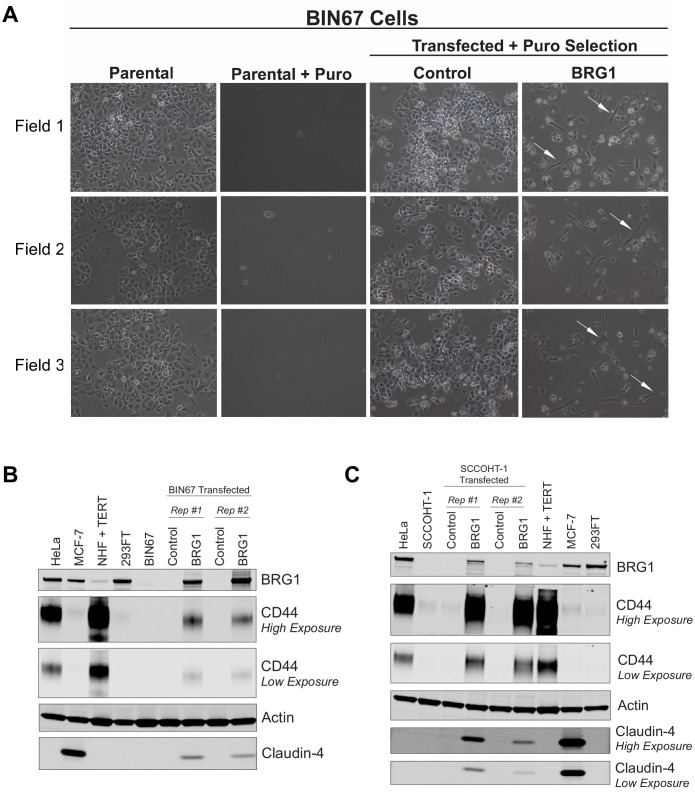
Morphology and protein expression changes in SCCOHT cells following BRG1 reexpression.(A) Three different fields taken randomly across two biological replicates of BIN67 cells +/- BRG1 reexpression flowing experimental design in Figure 1a. Pictures were taken at 10X phase prior to harvest. BIN67 cells transfected with BRG1 show an elongated morphology (white arrows) relative to control. BIN67 (parental) cells at similar passage are shown for morphology comparison. Untransfected controls treated with puromycin (Parental + Puro) are shown for each experiment. Control and BRG1 transfected for Field one are shown in Figure 1b. Field one is from biological replicate #1 and Field two and Field three are from biological replicate #2. (B, C) Western blots for (B) BIN67 and (C) SCCOHT-1 cells +/- BRG1 compared to other cancer cell lines. Reexpression studies were performed in biological duplicate.